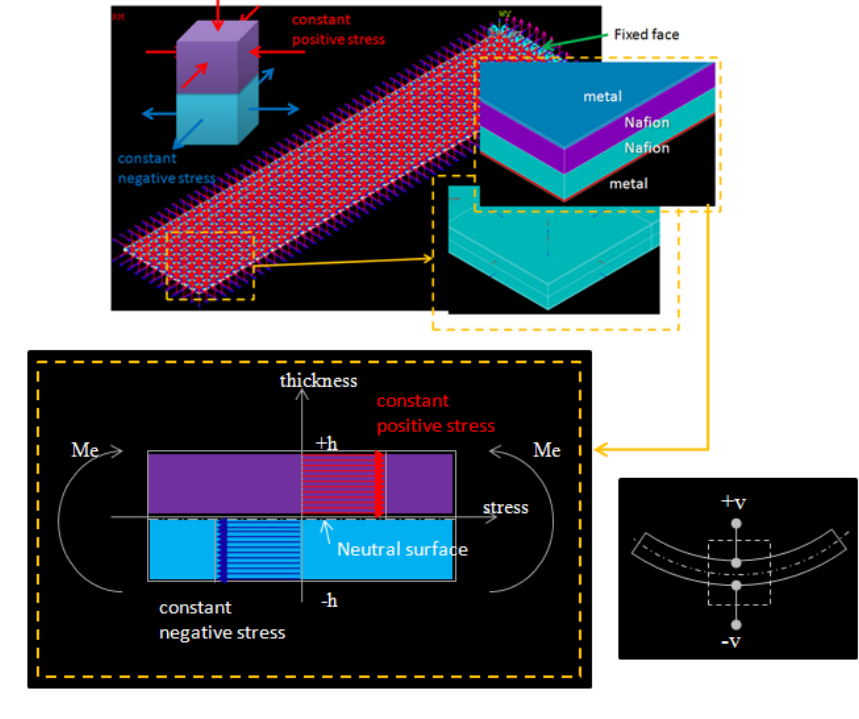
Figure 2. The structure and ANSYS ® element model of a cantilever beam shaped IPMC with the actuation mechanisms. Red and blue arrows stand for compressive and tensile stress. This configuration shows IPMC bent toward the anode.